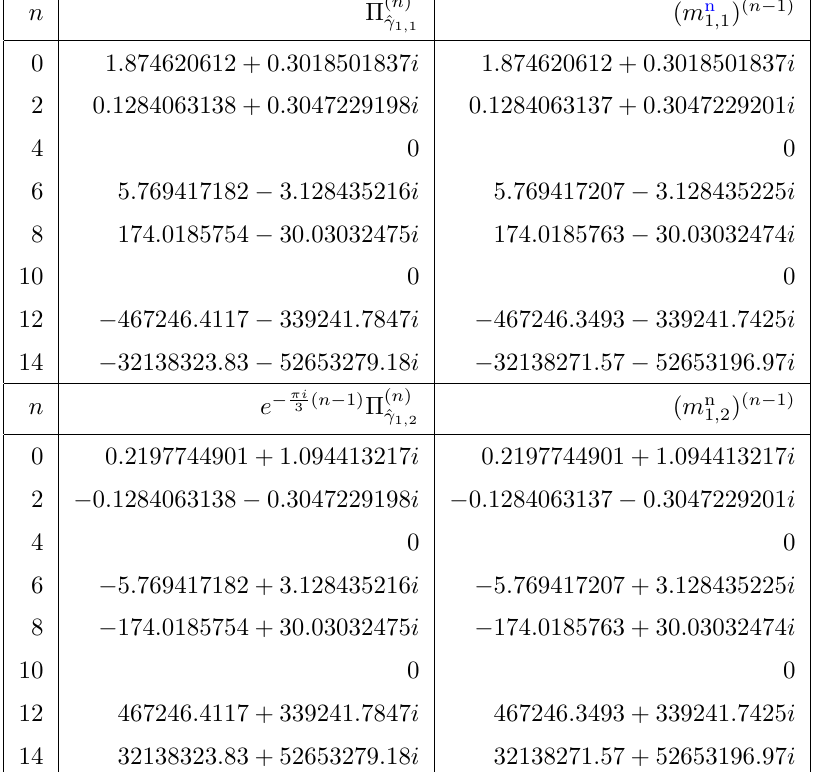
Table 4. Π ( n ) and ( m n ) ( n − 1) ( k = 1 , 2 ) for the third order ODE with p ( x ) = − x 3 − ix 2 +(1 − i ) x . 1 ,k ˆ γ 1 ,k